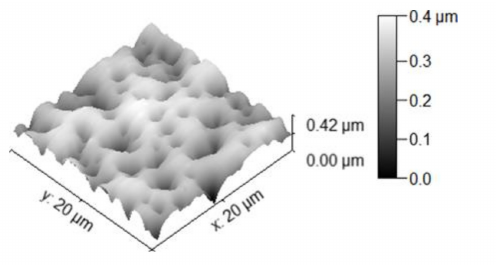
Figure 5. Three-dimensional AFM image of the thiol-ene surface hot embossed at 100 ◦ C under 10 MPa.